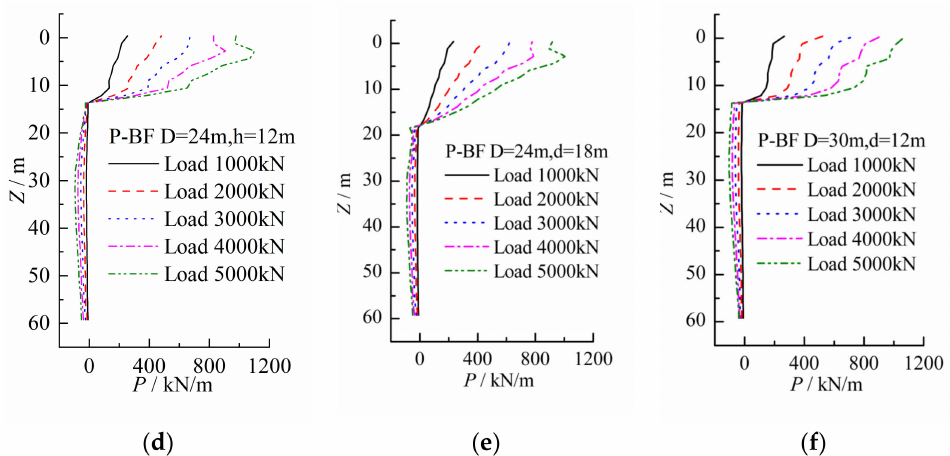
Figure 12. The subgrade reaction force distribution of PF and P–BF. ( a ) The subgrade reaction distribution. ( b ) The subgrade reaction distribution. ( c ) The subgrade reaction distribution of PF of P–BF; D / h = 18 m/12 m D / h = 24 m/6 m. ( d ) The subgrade reaction distribution. ( e ) The subgrade reaction distribution. ( f ) The subgrade reaction distribution of P–BF; D / h = 24 m/12 m of P–BF, D / h = 24 m/18 m of P–BF, D / h = 30 m/12